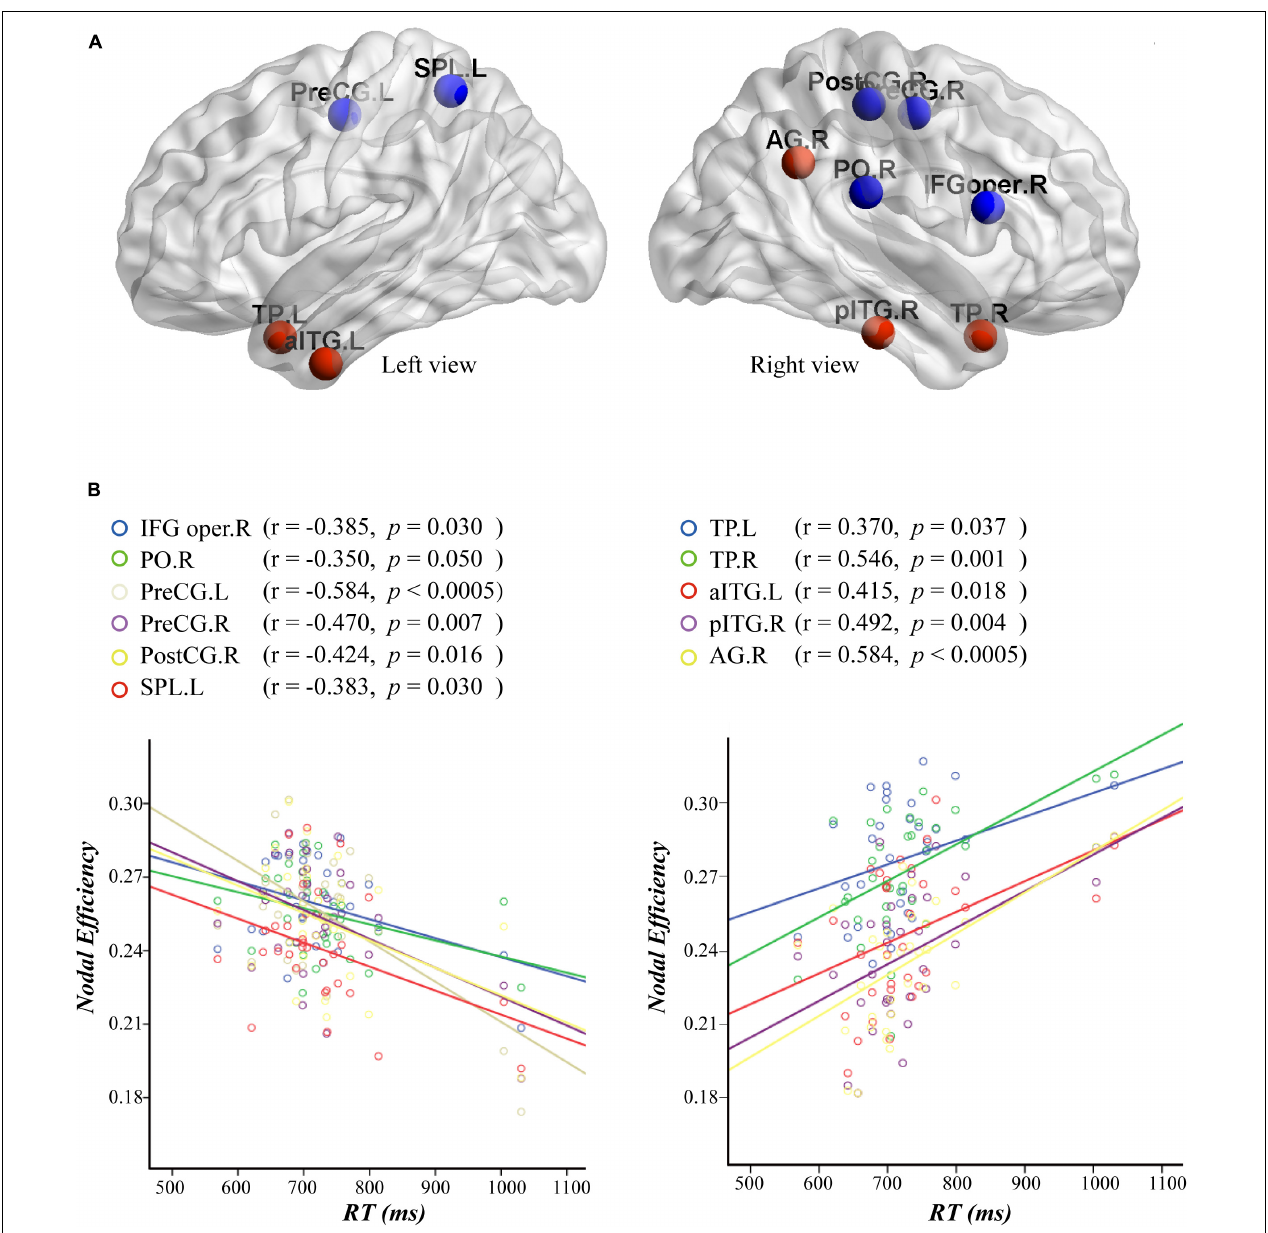
FIGURE 7 | (A) Nodes with an efficiency value significantly correlated to the reaction time (RT) are mapped to the cortical surface. The efficiency values of nodes in red and blue are positively and negatively correlated with RT, respectively. (B) Scatterplots and robust regression fitting lines for negative (left) and positive (right) correlations between nodal efficiency and RT. The results of correlation analysis and the activation value of the nodes in parentheses. AG, angular gyrus; aITG, anterior inferior temporal gyrus; IFG oper, pars opercularis inferior frontal gyrus; pITG, posterior inferior temporal gyrus; PO, parietal operculum cortex; PostCG, postcentral gyrus; PreCG, precentral gyrus; SPL, superior parietal lobule; TP, temporal pole; L, left; R,